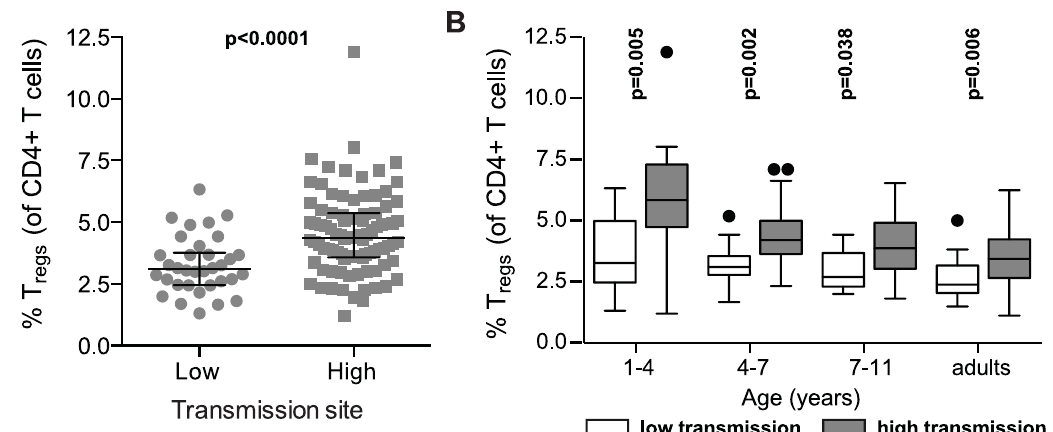
District (n = 34) were compared to children in the high transmission Tororo District (n = 91). Wilcoxon ranksum p value indicated. (B ) FoxP3+CD25 +CD127 dim regulatory T cell frequencies were compared between children from low and high transmission areas at age 1 – 4 (n = 11 and n = 18), 4 – 7 (n = 14 and n = 35) and 7 – 11 (n = 9 and n = 38) years of age and adults (n = 9 and n = 37). Wilcoxon ranksum for age group comparisons, p values indicated.